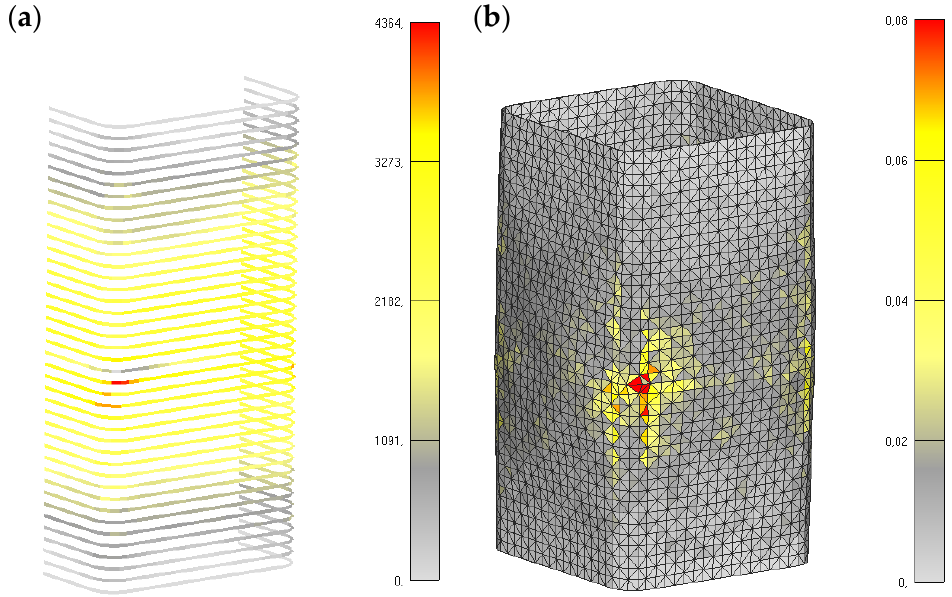
Figure 11. Typical failure mode R 15: ( a ) tensile rupture of fibers and ( b ) damage inside the resin.